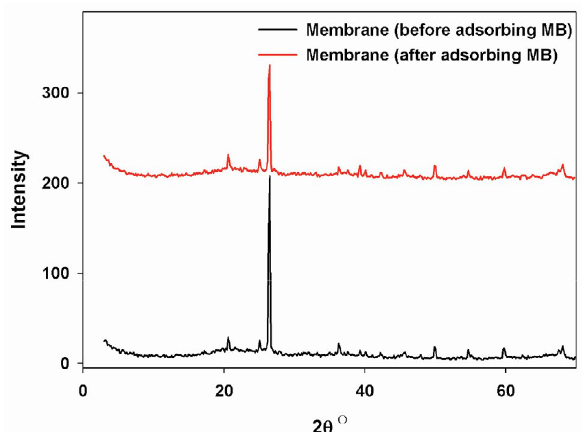
Figure 8. UV-Vis absorption spectra with inset photos for the col- lected eluents form D membrane immersed in MB aqueous solu- tions resulting from adsorption reactions after 120 min., 24 hours and regeneration cycles R1 and